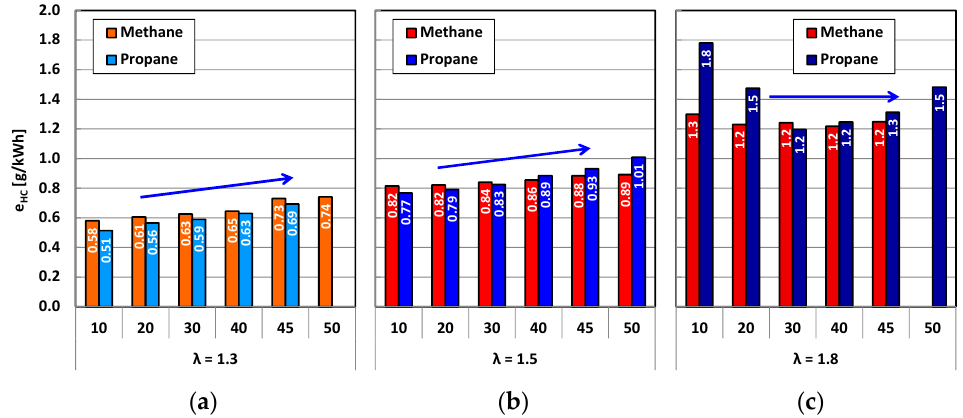
Figure 16. Carbon monoxide emissions at di ff erent values of energy supplied to the prechamber: